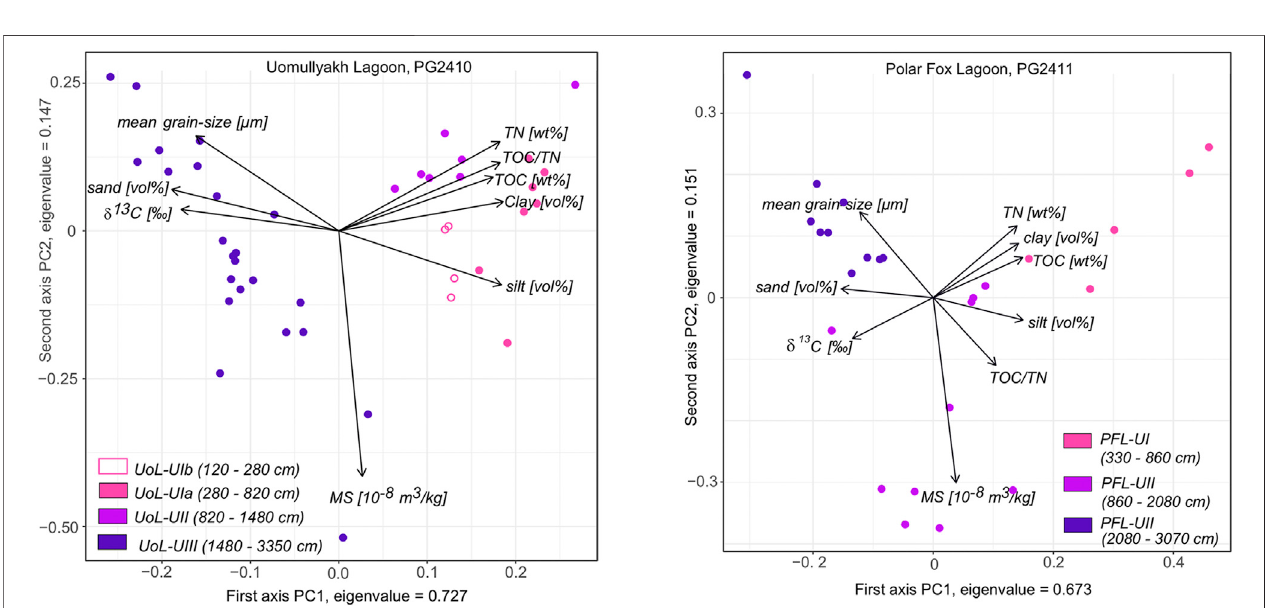
FIGURE5| Principalcomponentanalysisofbiogeochemicalparameter(TN,TOC/TN, TOCand δ 13 C)andsedimentological parameter(volumetricandmeangrain size, MS) for Uomullyakh Lagoon (left) and Polar Fox Lagoon (right) . Main variance in the data is explained by differences in grain size and organic matter content and composition along the core.